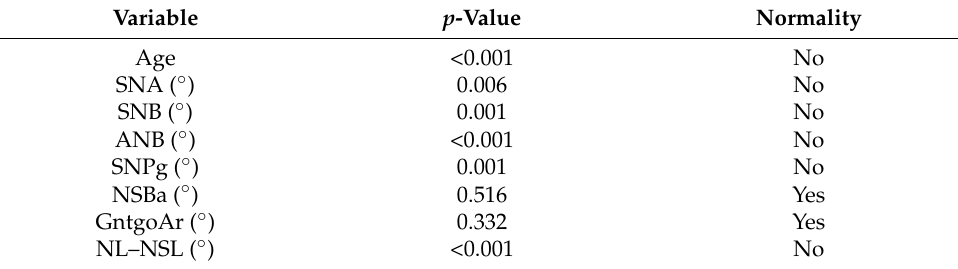
Table 4. Data normality (Shapiro–Wilk test, p <